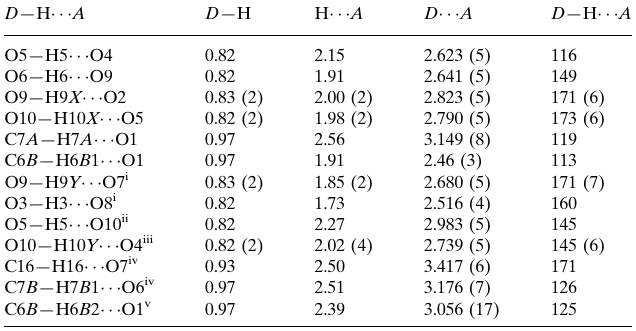
Hydrogen-bond geometry (A˚ , (cid:4)